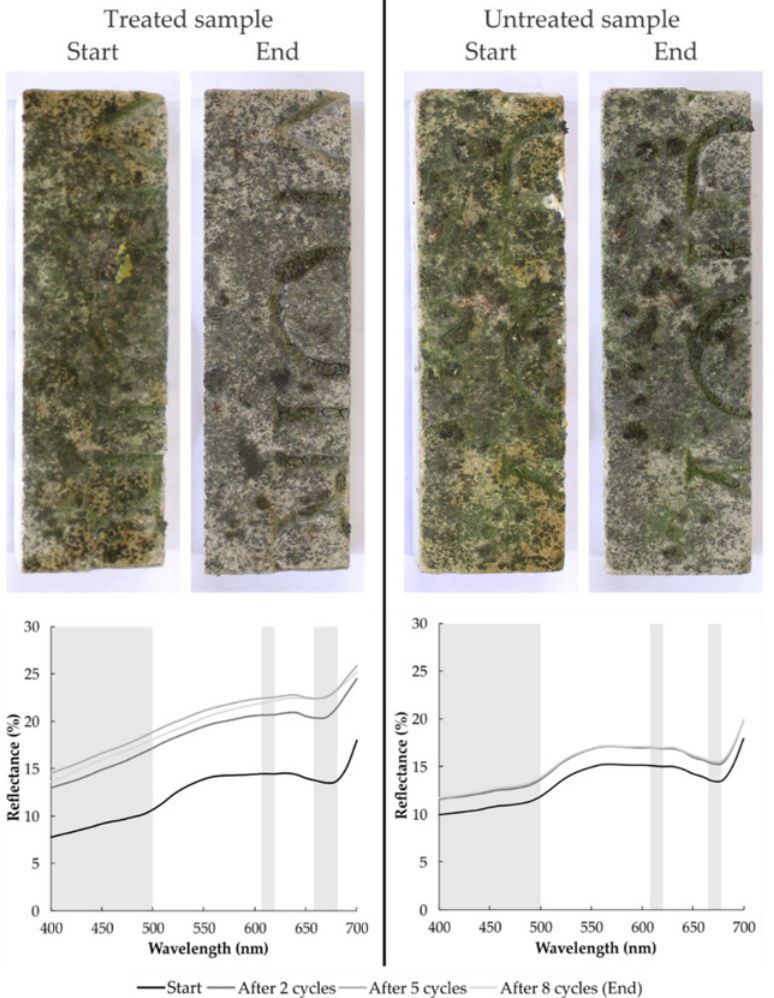
Figure 3. Appearance of a representative treated (Sample 2) and untreated (Sample 8) biofouled stone at the start and end of the experiment and spectral reflectance graphs showing the evolution of the spectra over time. The areas of chlorophyll absorption are indicated in